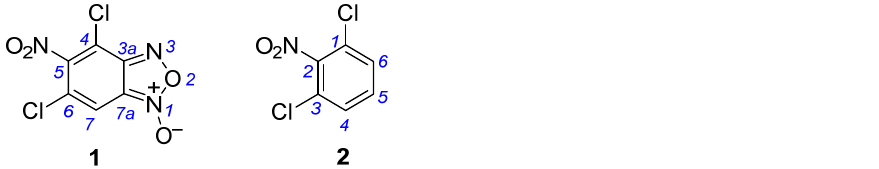
Figure 1. Structure of 4,6-dichloro-5-nitrobenzofuroxan ( 1 ) and of 1,3-dichloro-2-nitrobenzene ( 2 ).